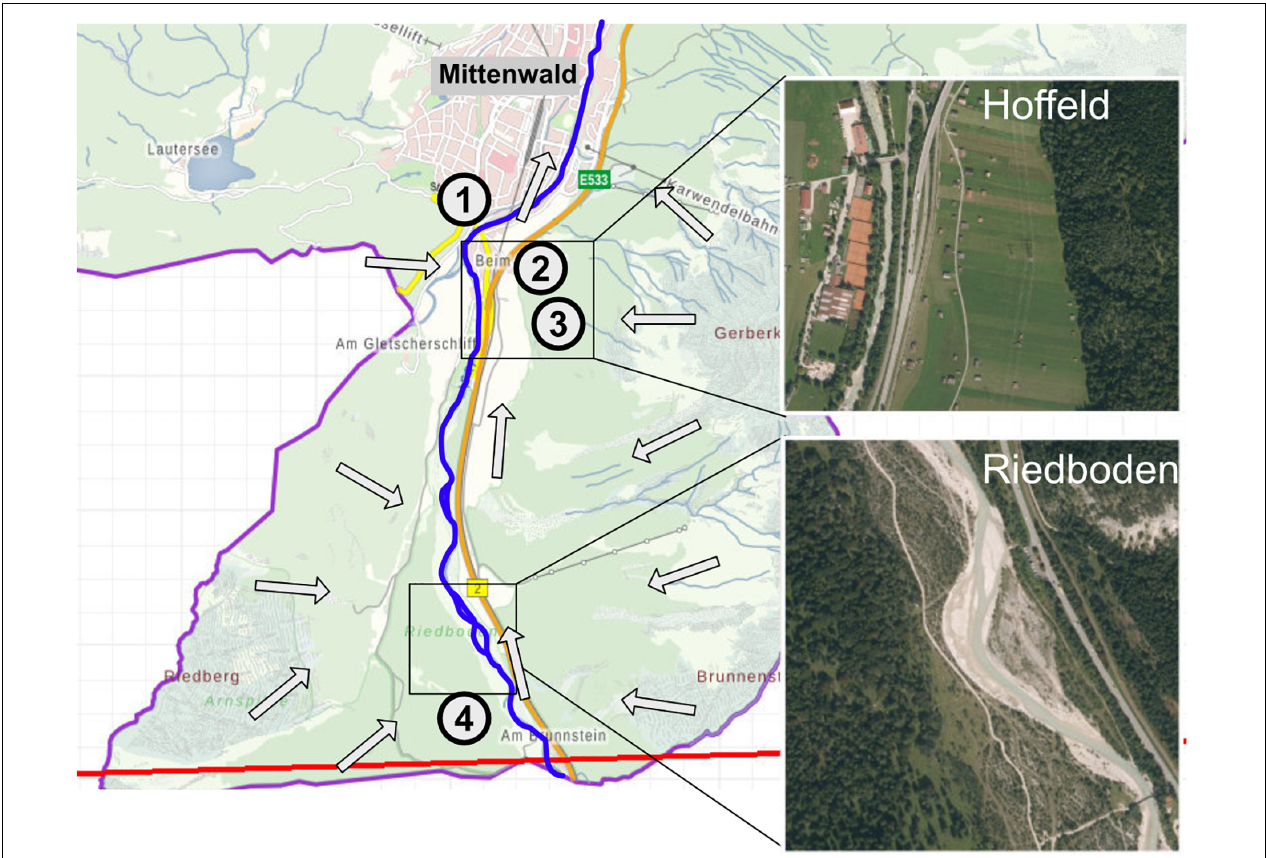
FIGURE 2 | Map highlighting the location of the selected groundwater monitoring wells and the Isar River. Arrows indicate the general direction of groundwater flow. Wells MIT037 (1), MIT038 (2), and MIT039 (3) are distributed in the area of “Hoffeld” close to the village of Mittenwald, while well MIT052 (4) is located in the mountain pasture “Riedboden.” While the “Hoffeld” is dominated by meadows and hayfields, the “Riedboden” is interspersed with pine trees and shrubs. Satellite images provided by Google Maps